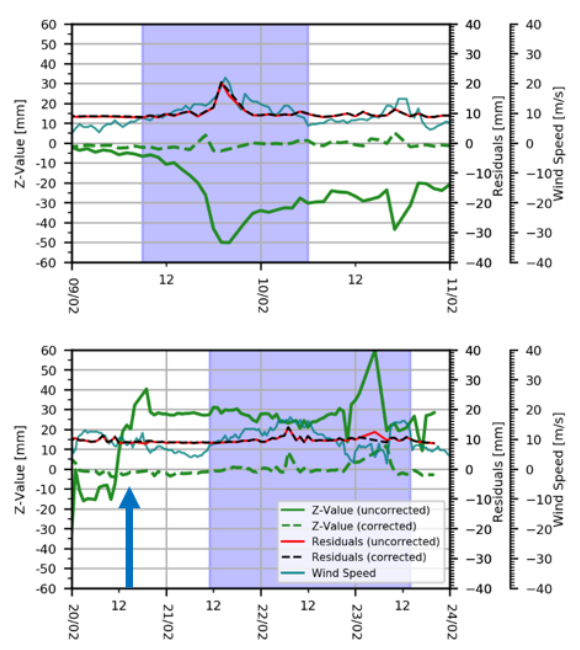
Figure 5. Plane estimation at helipad and comparison of the parameters with the weather data during storm Ciara (top panel) and storm Yulia (bottom panel). The stormy periods are marked with a blue background. The jump (marked with arrow) in the mean z-coordinate of the helipad around noon on 20/02/2020 was caused by maintenance